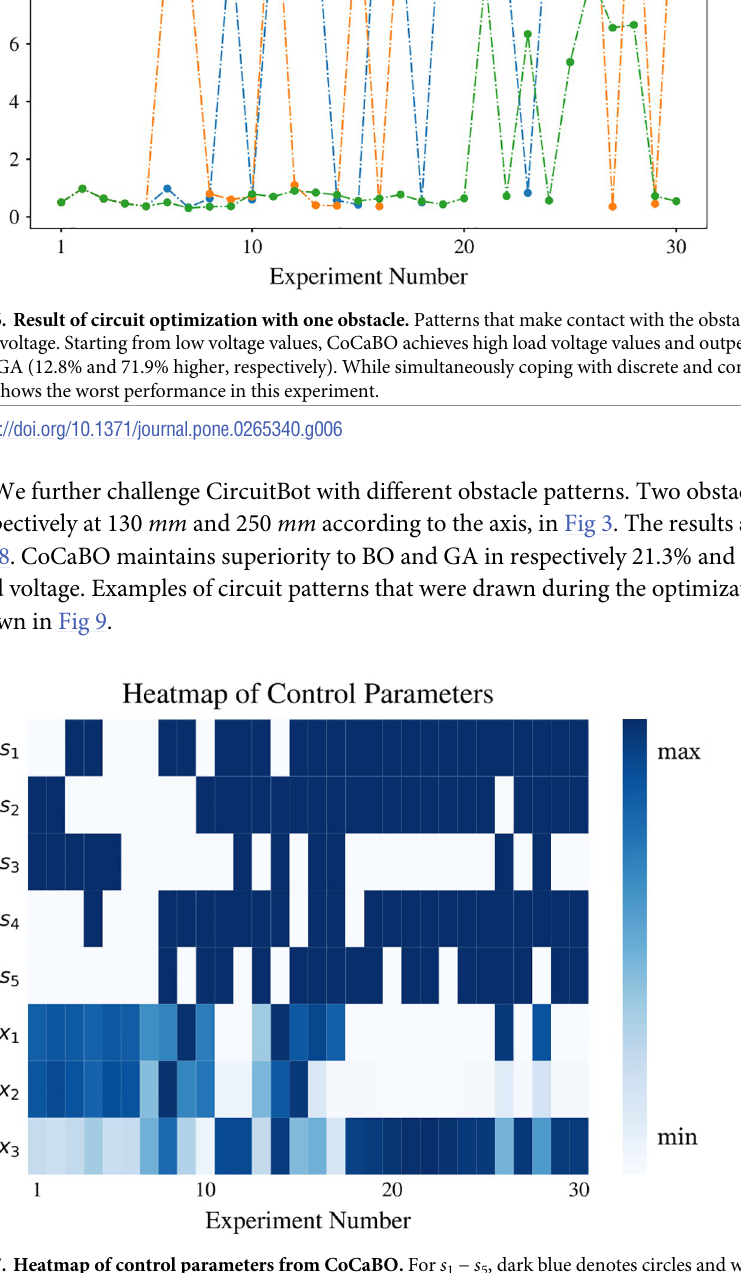
Fig 7. Heatmap of control parameters from CoCaBO. For s 1 − s 5 , dark blue denotes circles and white denotes lines. The obstacle can be avoided if s 1 , s 2 and s 3 are all lines or s 1 and s 3 are circles centered away from the middle of the workspace. When s 2 and s 4 are both circles, the robot learns to constrain x 1 and x 3 in a small search area to prevent connecting the obstacle.